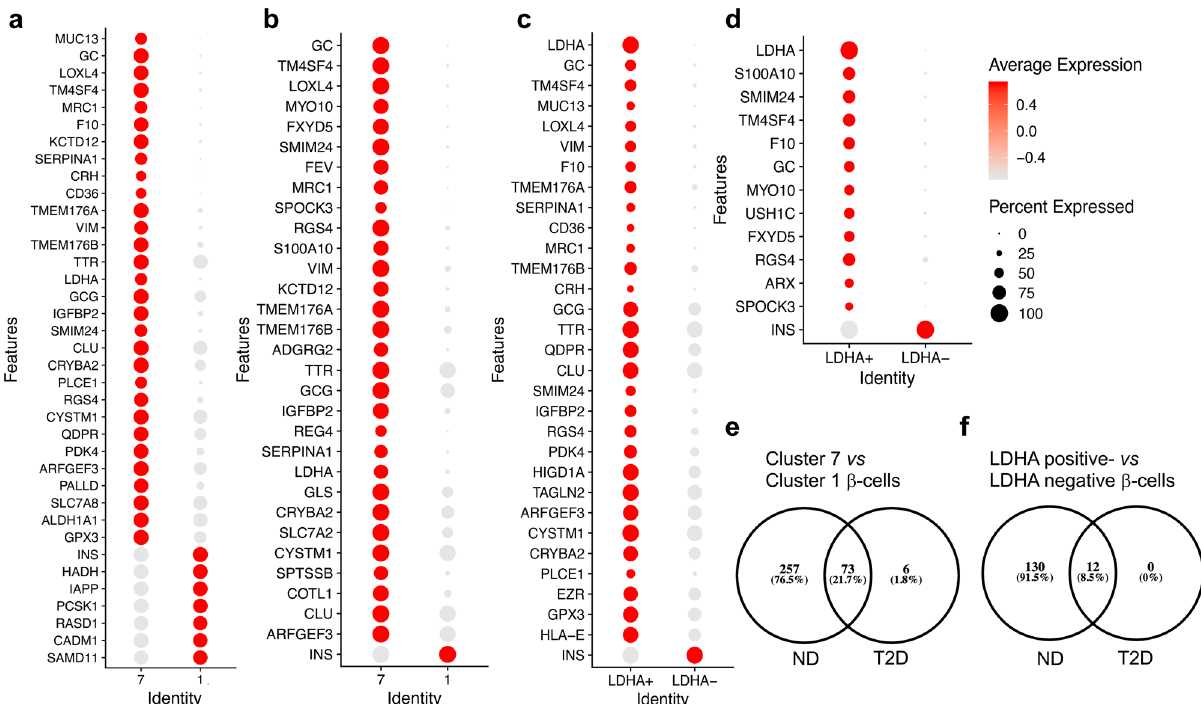
Fig. 6 Differential-expression analysis comparing LDHA-positive and LDHA-negative β -cells from healthy and T2D donors. a Dot plot showing the differentially expressed genes between cluster 7 and cluster 1 β -cells in non-diabetic donors (ND). The size of the dots represents the percentage of cells the gene was detected in. The colour scale represents the scaled expression of the gene in the two groups. The Wilcoxon rank-sum test was performed in the differential expression analysis, and the Benjamini – Hochberg procedure was applied to adjust the false-discovery rate. Genes with adjusted p -value less than 0.05 were considered signi fi cantly differentially expressed. b Dot plot showing the differentially expressed genes between cluster 7 and cluster 1 β - cells in T2D. c Dot-plot showing the differentially expressed genes between LDHA-positive and LDHA-negative β -cells from non-diabetic donors (ND). d Dot plot showing the differentially expressed genes between LDHA-positive and LDHA-negative β -cells from T2D. e Venn diagram from the results presented under ( a ) and ( b ). ( f ) Venn diagram from the results presented under ( c ) and ( d